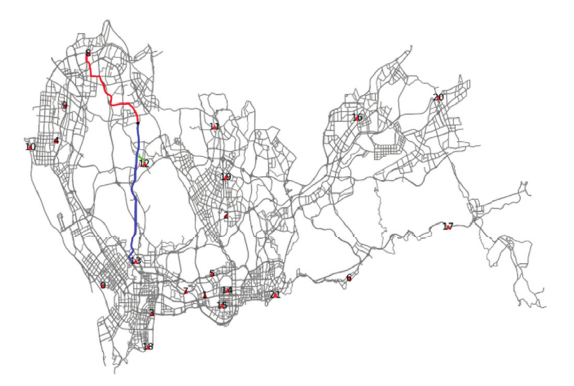
Figure 7: Charging path planning for single EV.